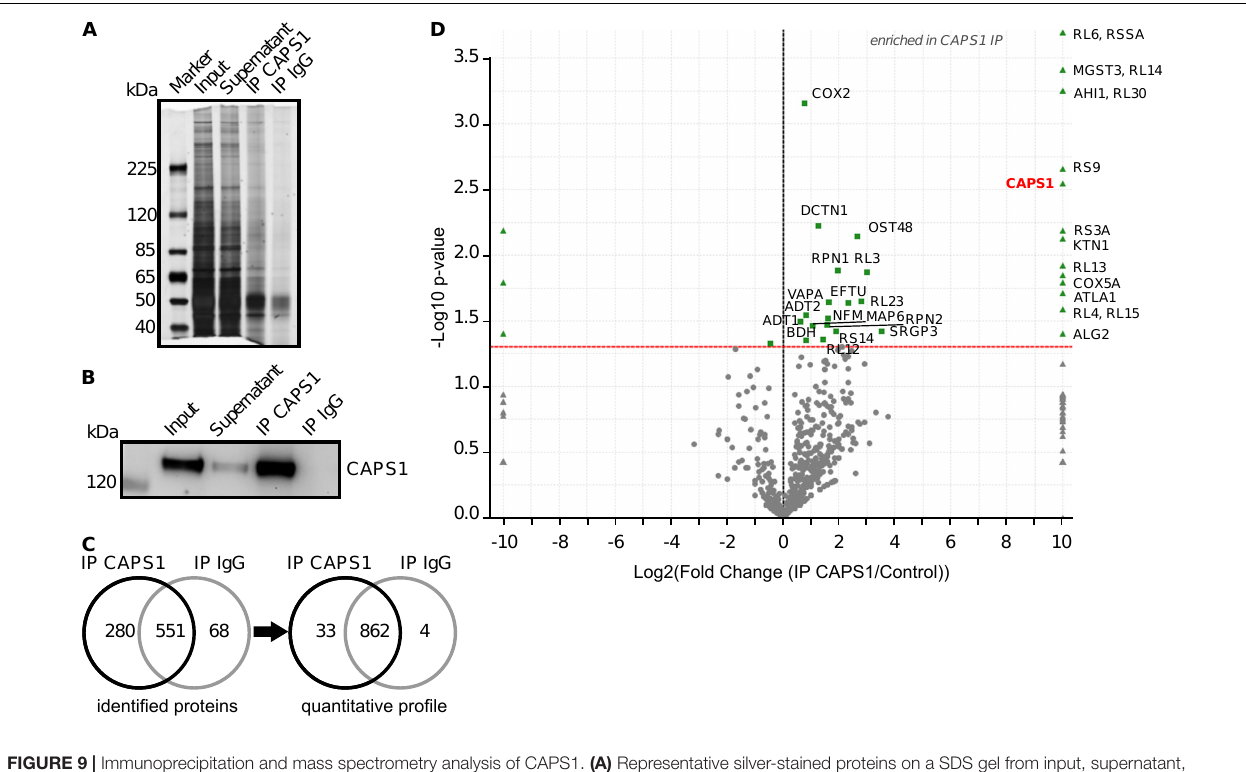
FIGURE 9 | Immunoprecipitation and mass spectrometry analysis of CAPS1. (A) Representative silver-stained proteins on a SDS gel from input, supernatant, CAPS1 IP, and IgG control IP. (B) Representative western blots of CAPS1 with the indicated bands for input, supernatant, CAPS1 IP, and IgG control IP. (C) Total spectrum count analysis of proteins identified in three independent eluates after CAPS1 IPs and IgG control IPs by nano-LC-MS/MS (minimum of 2 peptides/protein). Left: number of protein identifications, right: semi-quantitative profile showing proteins significantly enriched ( n = 3 for CAPS1 and IgG, t -test, p < 0.05). (D) Volcano plot of p -value vs. x-fold change of identified peptide spectrum counts. Proteins that were significantly enriched with CAPS1 or IgG antibodies with a p -value < 0.05 ( t -test) are highlighted in green. The CAPS1 protein (red) is exclusively identified in all CAPS1 IPs from whole mouse brain lysates ( n = 3, biological replicates for CAPS1 IPs and IgG